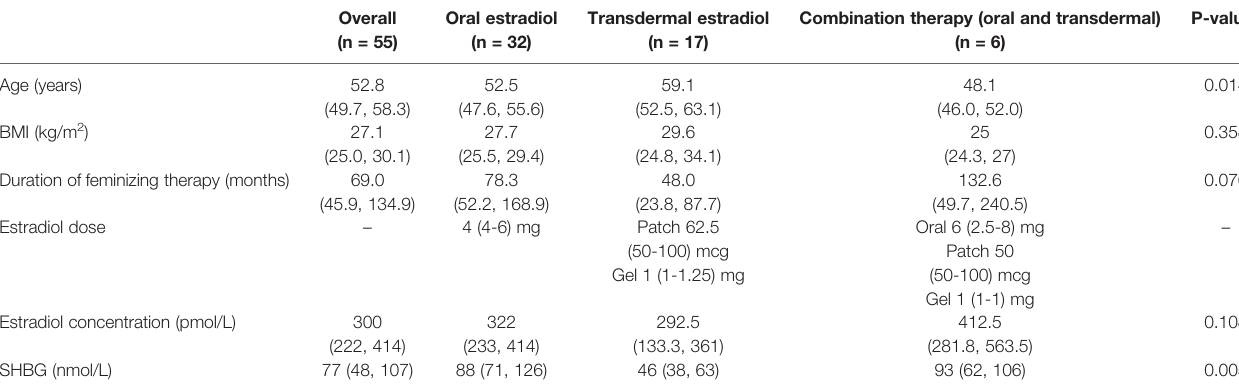
TABLE 1 | Clinical Characteristics ( ≥ 45 years age